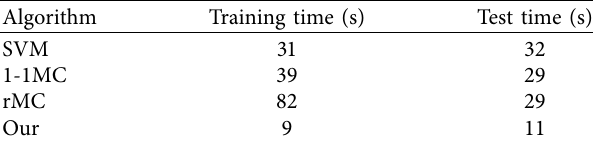
Table 5: Comparison of training and testing time.